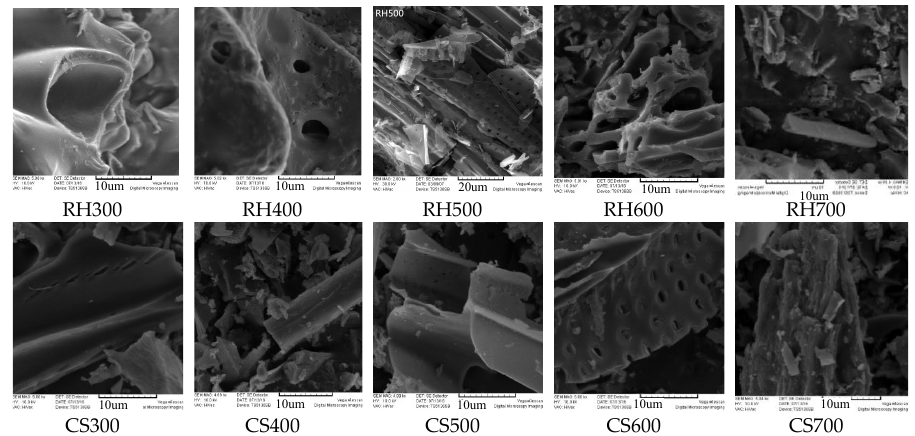
Figure 1. Scanning electron microscopy (SEM) images of the biochar materials obtained from rice husk (RH) and cotton straw (CS) at various pyrolysis temperatures (300, 400, 500, 600, and 700 °C).